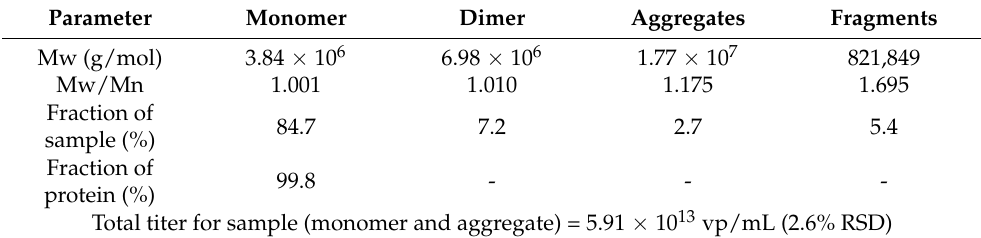
Table 2. Quantitative parameters for rAAV5 (Empty).